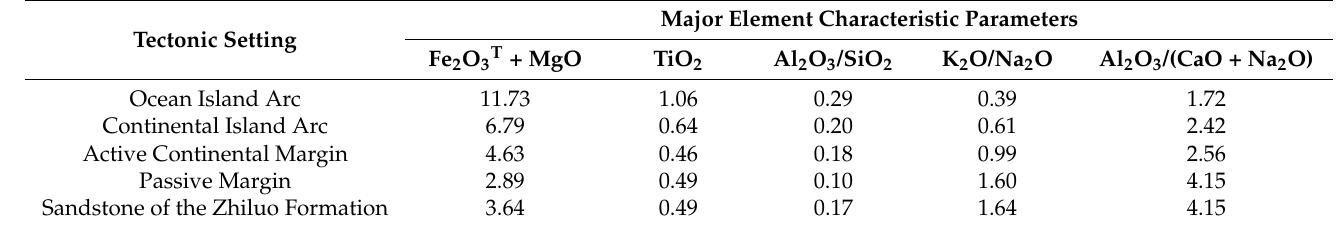
Figure 12. Plots of major element composition of the Zhiluo Formation sandstones using tectonic discrimination diagrams: ( a ) SiO 2 versus K 2 O/Na 2 O bivariate diagram [36], ( b ) K 2 O/Na 2 O versus SiO 2 /Al 2 O 3 bivariate diagram [52] and ( c ) Fe 2 O 3T + MgO versus Al 2 O 3 /(Na 2 O + CaO) bivariate diagram [53]. PM = passive margin; ACM = active continental margin; ARC, A1and A2 = arc; CIA = continental island arc; OIA = ocean island arc. Table 5. Comparison of characteristic parameters of major elements of sandstones between the Zhiluo Formation and other tectonic